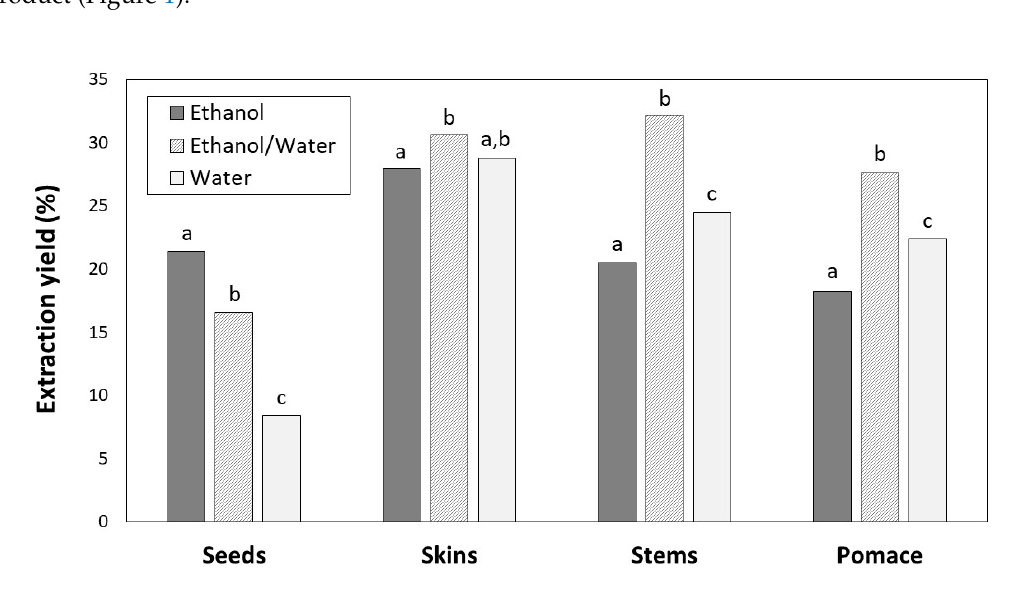
Figure 1. Extraction yields for seeds, skins, stems and pomace depending on the solvent (ethanol, ethanol/water and water). For the same byproduct, different letters indicate significant differences ( p < 0.05) between ethanol, ethanol/water and water extracts by Tukey's test.